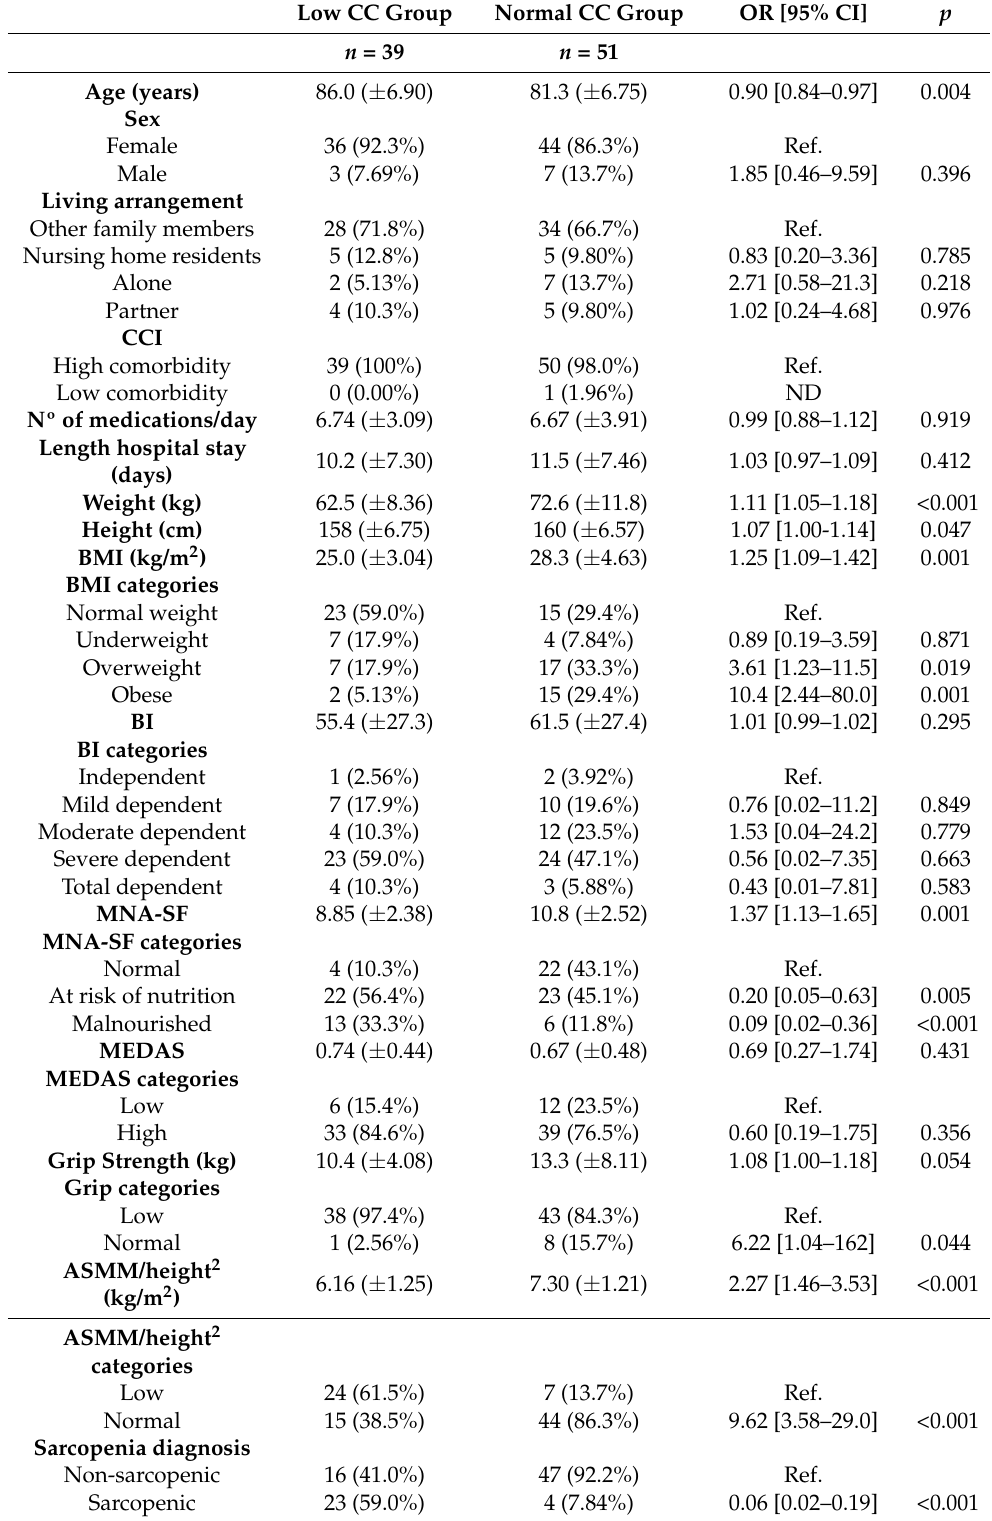
Table 3. Characteristics of older patients hospitalized for hip fractures according to